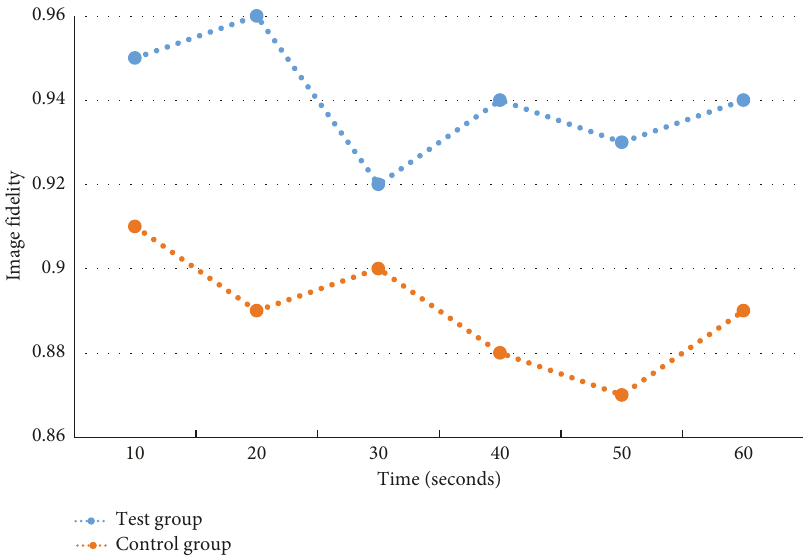
Figure 8: Image fidelity results from two sets of film and television